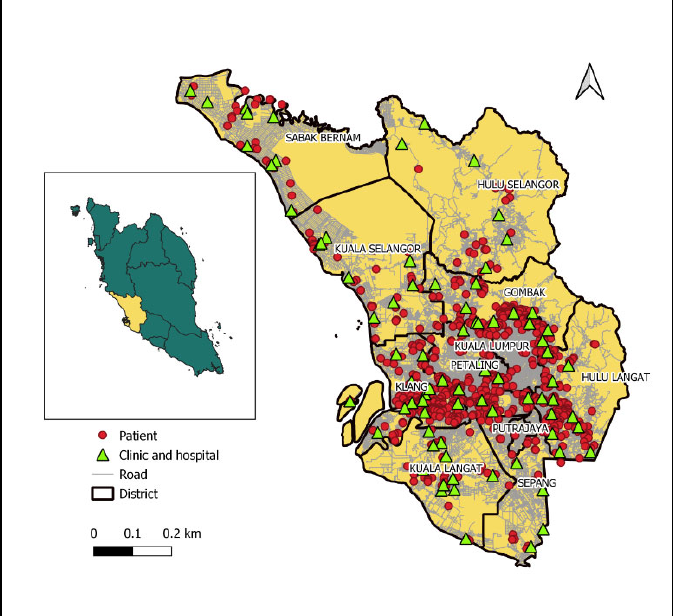
Figure 1. Distribution of pulmonary tuberculosis patients and public healthcare facilities in the state of Selangor, Malaysia.